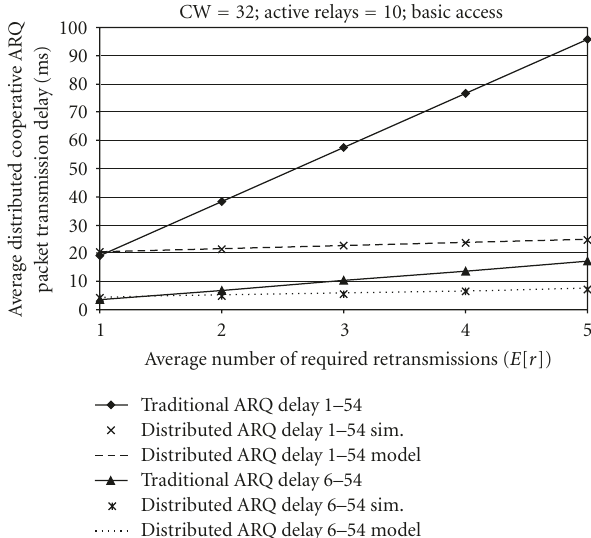
Figure 6: Average distributed cooperative ARQ packet transmission delay as a function of the transmission rate (relay low-rate regime).